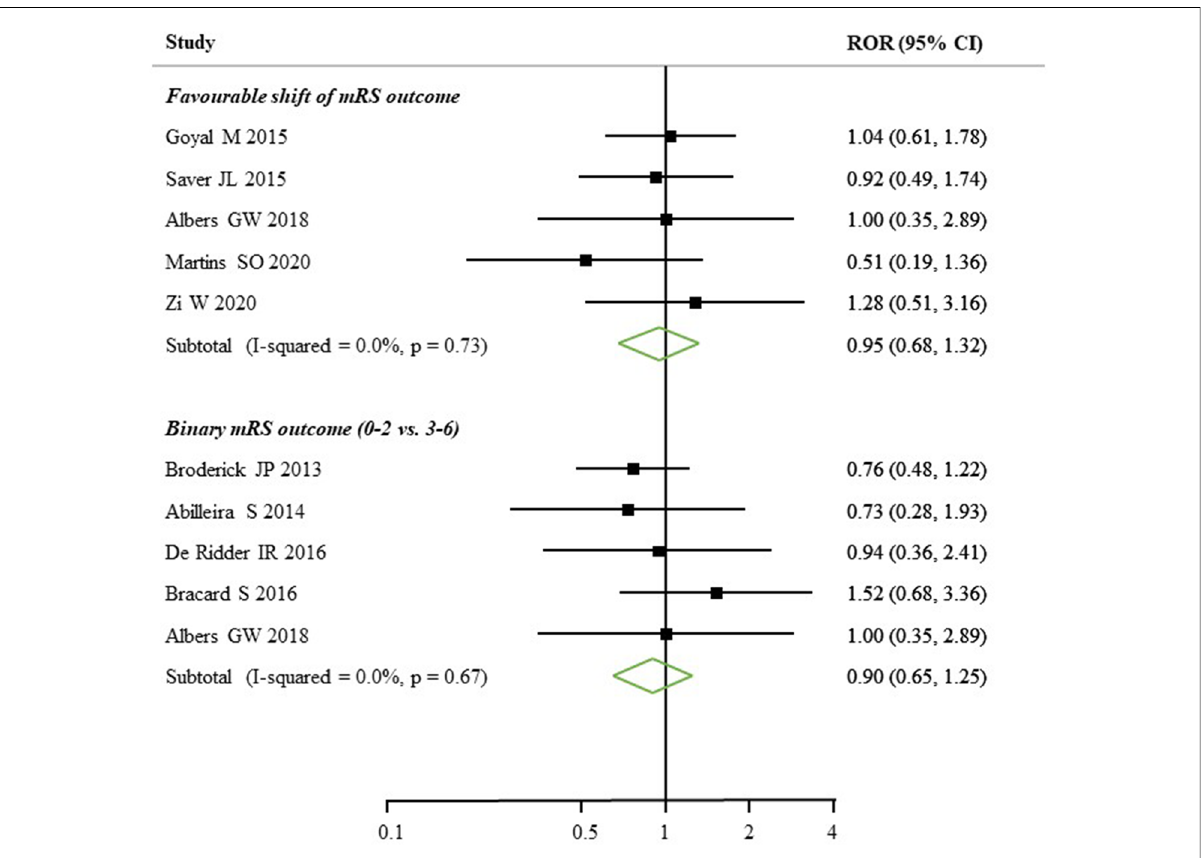
FIGURE 4 Women to men ratios of sex-speci fi c odds ratios, with 95% con fi dence intervals (CIs), of functional outcomes after EVT treatment. mRS, modi fi ed Rankin scale; ROR, relative ratio of odds